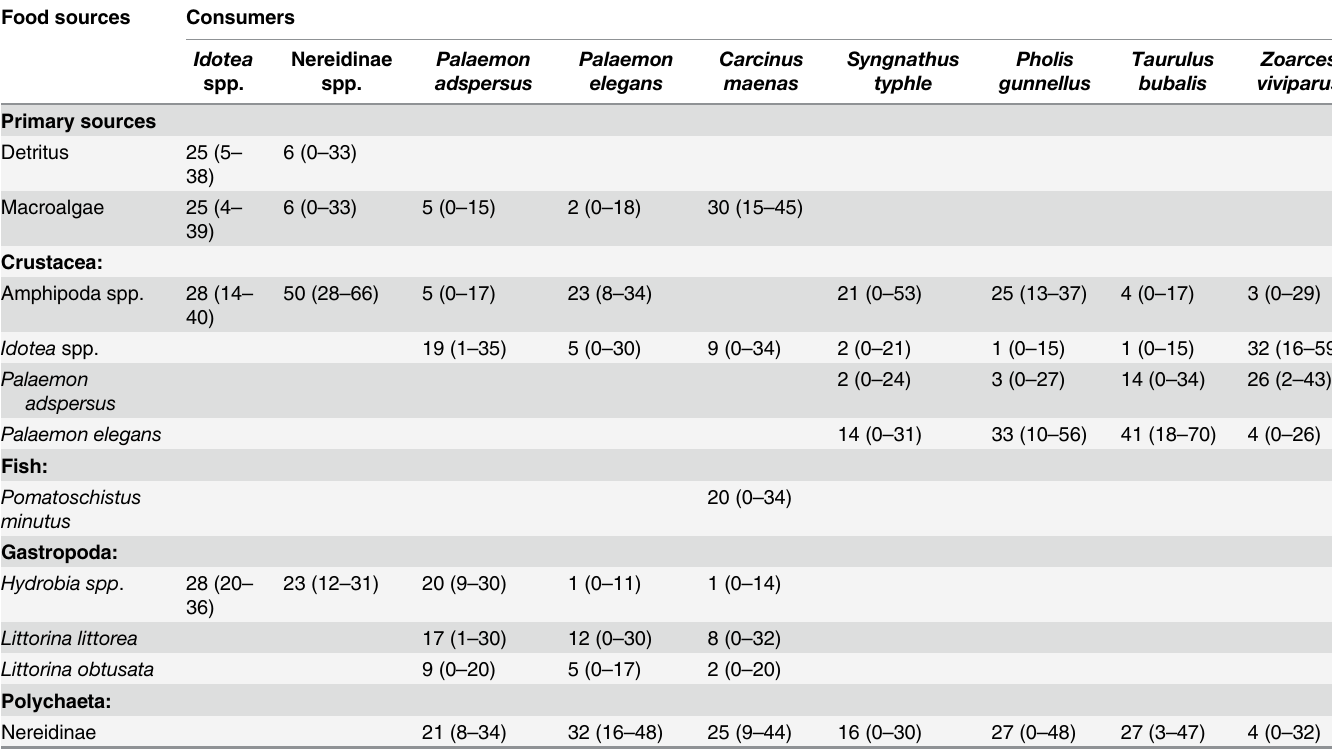
Table 5. Proportional (%) contribution of food sources to selected consumers in Dalby Bay,